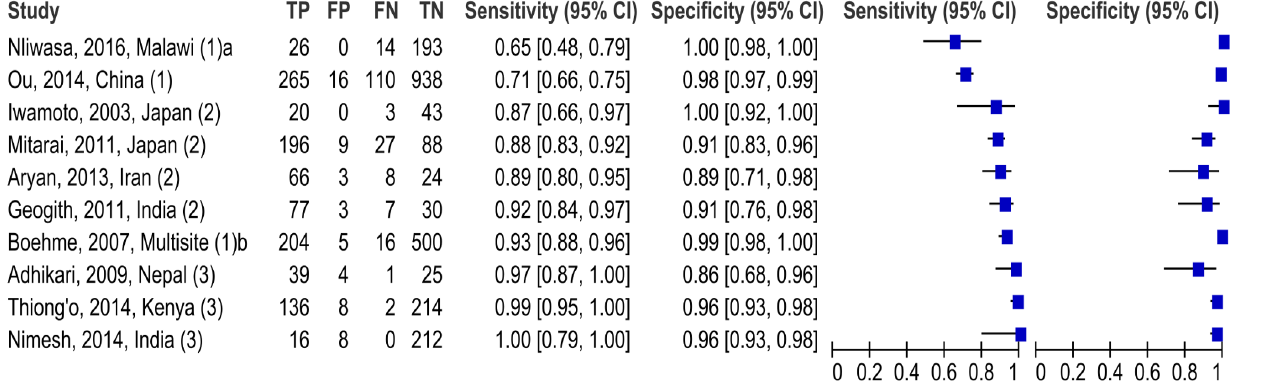
Fig 3. Studies of accuracy of LAMP for diagnosis of tuberculosis. Abbreviations: TP = true positive; FP = false positive; FN = false negative; TN = true negative. Study setting: 1 Primary care; 2 Hospital; 3 University or national reference laboratory. a Refers to findings of this study in Malawi. b Study sites were in Peru, Bangladesh, Tanzania.